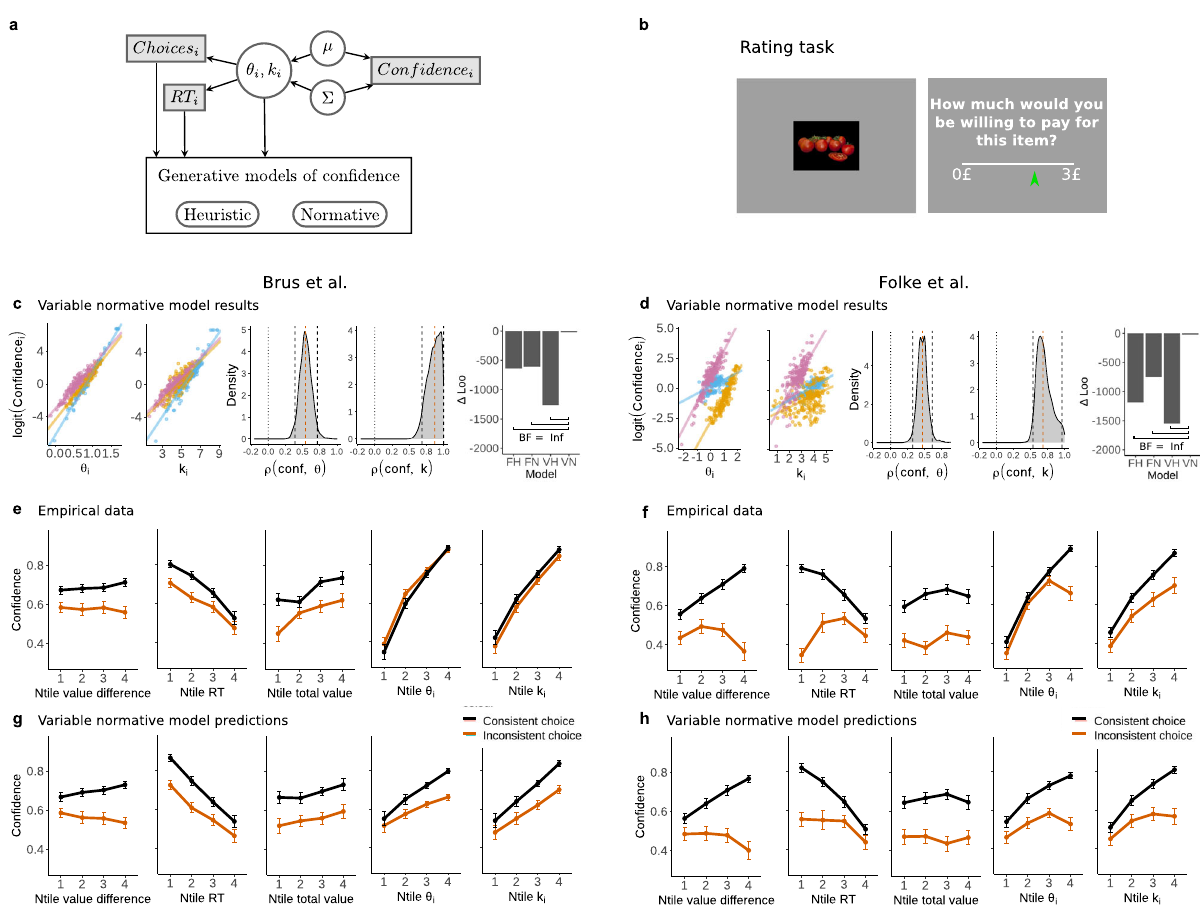
Fig. 3 Joint modeling, the covariance approach. a Graphical diagram for the joint model with the covariance approach. White circular nodes represent latent variables, grey rectangular nodes represent observable variables. The variables θ i , k i , and choices and reaction times feed into the generative models of con fi dence. b Folke et al. performed similar experiments, with the key difference that the rating task is not repeated. Furthermore, subjects were asked how much they were willing to pay for a certain food item using a standard incentive-compatible Becker – DeGroot – Marschak method. c Results from the variable normative model and model comparison. Con fi dence is positively related to trial-to-trial fl uctuations of attentional effort and evidence gain, shown for three example subjects (for all subjects see Supplementary Figs. 7 and 8). The estimated density of correlation parameters for con fi dence and attentional effort and for con fi dence and the evidence gain is bigger than zero. In both cases ρ mcmc > 0 with P < 0.001. The vertical red dashed line indicates the median, black lines indicate the 95% con fi dence interval. Loo model comparison of the fi xed heuristic (FH), variable heuristic (VH), fi xed normative (FN), and variable normative (VN) model versions show that the VN model explains the data best. The Bayes Factor (BF) is calculated between the variable normative model and all other models, for all comparisons we fi nd an in fi nite BF in favor of the variable normative model. d The same as ( c ), but for the Folke data. e The empirically found con fi dence levels as a function of (from left to right) value difference, reaction time, total value, attentional effort, and the evidence gain, split for consistent and inconsistent choice. Data are presented as mean values ± SEM. g The same as in e, but for the predictions of the variable normative model. f , h The same as in ( d ) and ( e ), but for the data of Folke et al. For the Brus et al. dataset n = 33 independent participants, for Folke et al. n = 28 independent participants. Source data are provided as a Source Data fi